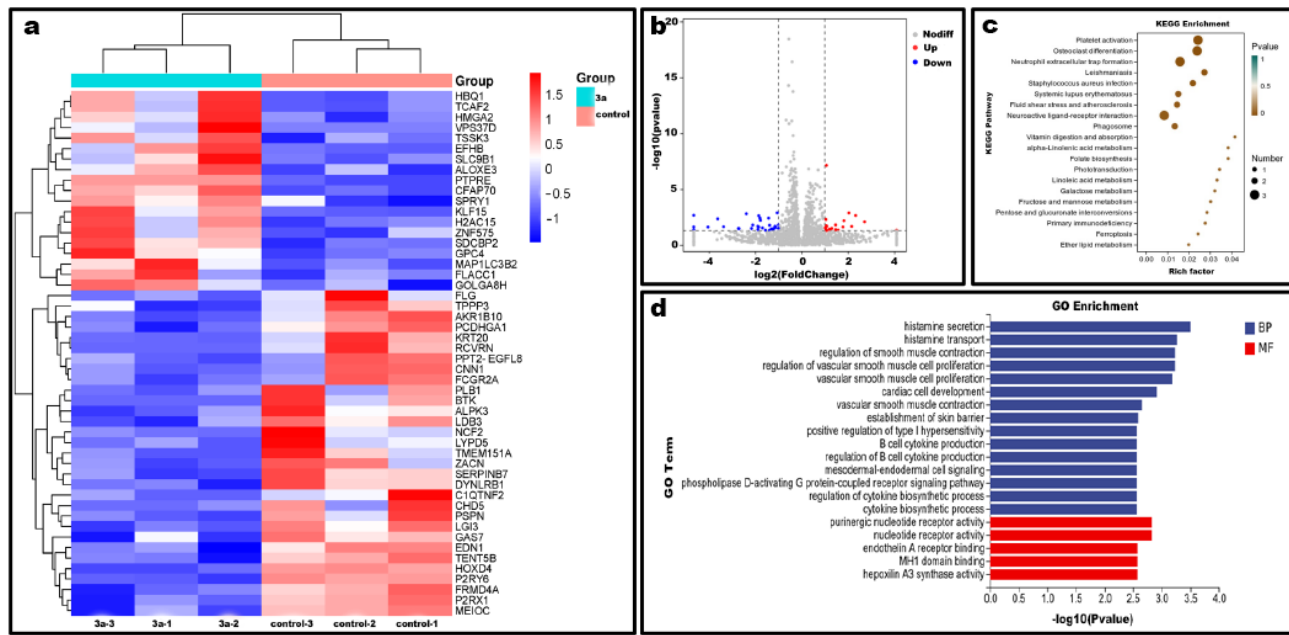
Figure 9. Statistical graph of differential gene expression. ( a ) Heat map. ( b ) Volcano map of differential gene expression. ( c ) KEGG pathway of differentially expressed genes. ( d ) GO enrichment analysis of differentially expressed genes.